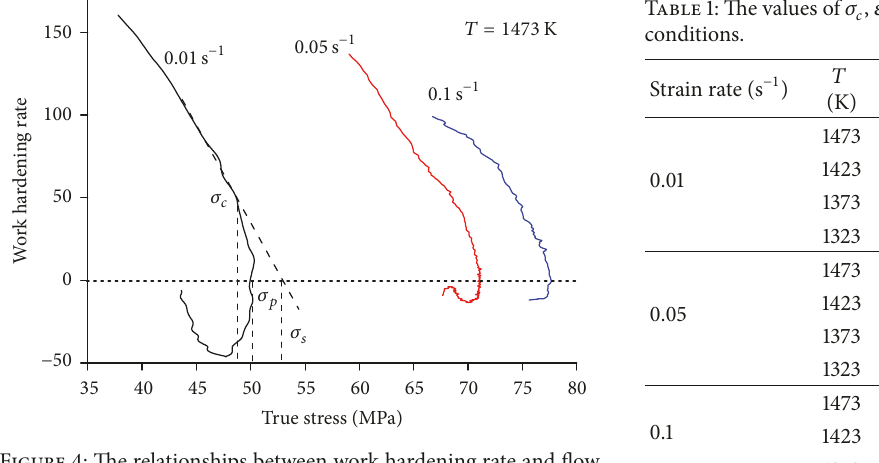
Figure 4: The relationships between work hardening rate and flow stress.